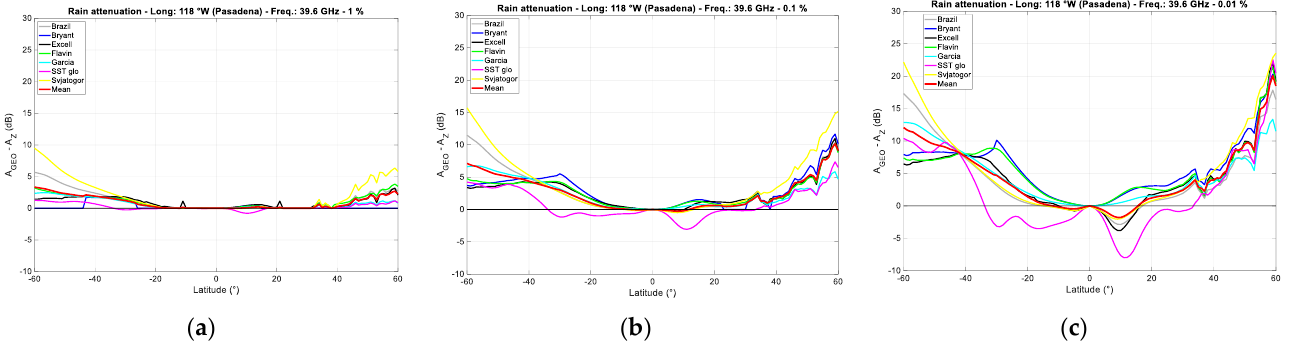
Figure 6. The difference A GEO − A Z , calculated at fixed annual probabilities 1% ( a ), 0.1% ( b ), and 0.01% ( c ), between the rain attenuation exceeded in the GEO path, A GEO , and the rain attenuation exceeded in the GeoSurf path, A Z , i.e., at the zenith in Pasadena; 39.6 GHz, circular polarization.